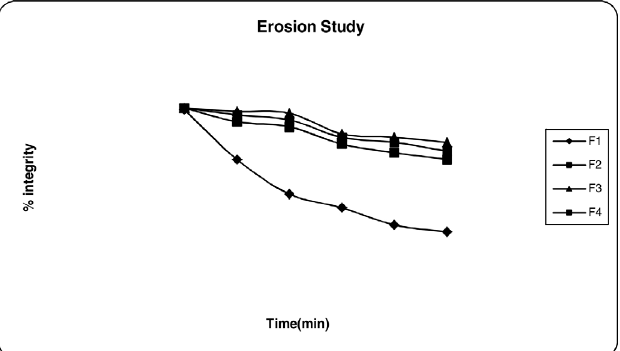
FIGURE 3 - Bead erosion in phosphate buffer pH 7.4 (mean ± S.D.; n=3): of F1 only SA beads; F2, F3, F4 are SCMC and CH modified SA